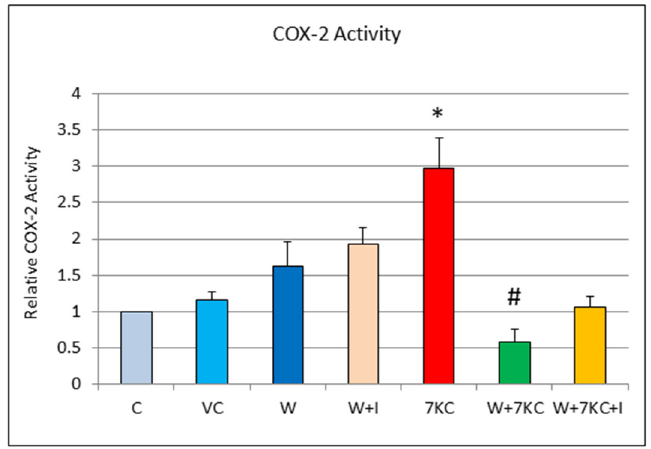
Figure 3. Effect of withanolide A and 7KC on COX-2 enzymatic activity. Significant increase in COX-2 activity was observed after treatment of cells with 7KC. This increase was significantly reduced by withanolide A. The modulatory effect of withanolide against increase in COX-2 activity was partially reduced (non-significant) when the cells were co-treated with withanolide A and mifepristone plus 7KC. C: Control, VC: Vehicle control, 7KC: 30 μM 7KC, W: 1 μM withanolide I: 10 μM mifepristone. Data are represented as mean ± SD ( n = 4). * Significant difference compared to controls. # Significant difference compared to 7KC (both p < 0.01).